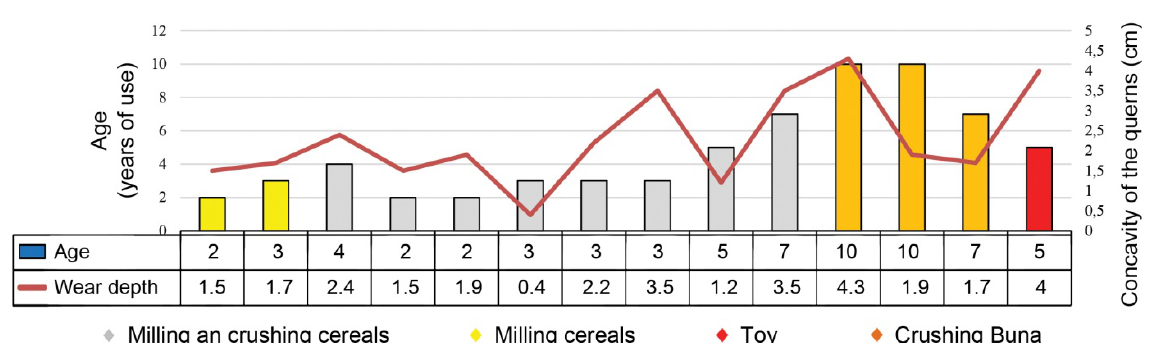
Figure 17. Comparison between the years of the use of the querns with the depth of the wear on their active surfaces. No correlation is found between the duration of use and the depth of the active surfaces, irrespective of the type of food that is